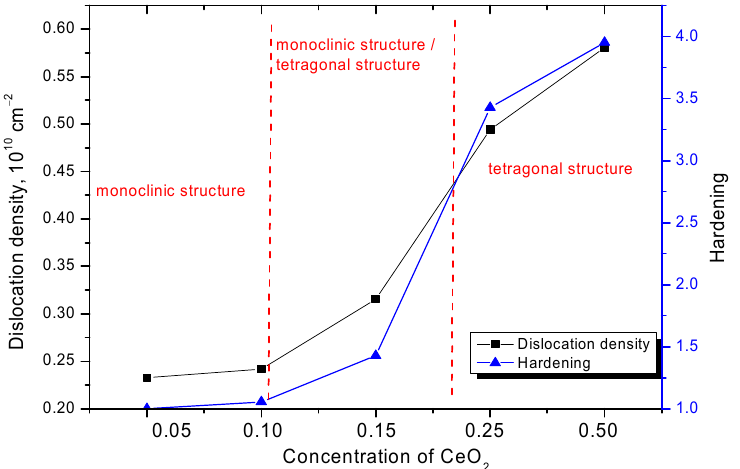
Figure 6. Dependence of the change in the dislocation density and the hardening degree of ceramics on the CeO 2 concentration in the composition of ceramics.